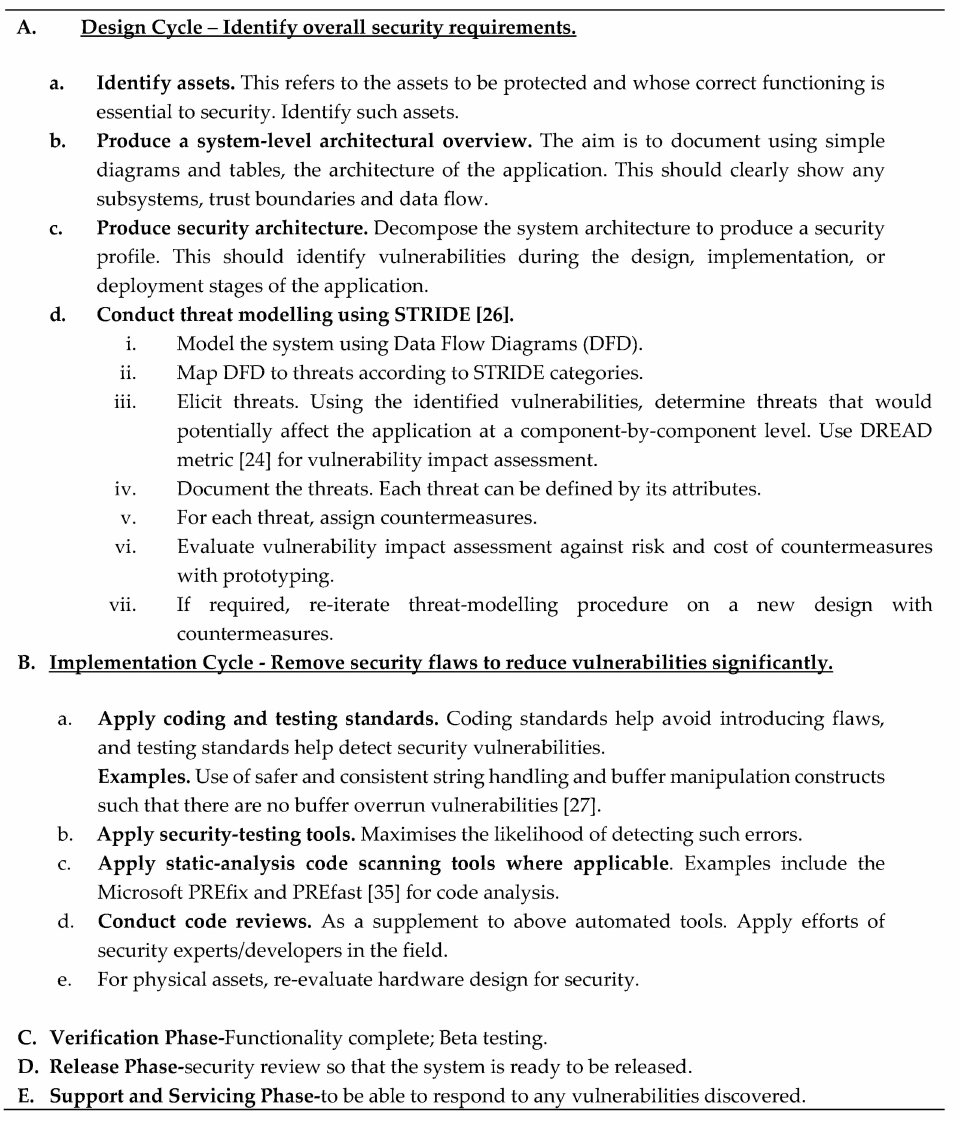
Figure 5. Threat Modelling as part of Security Development